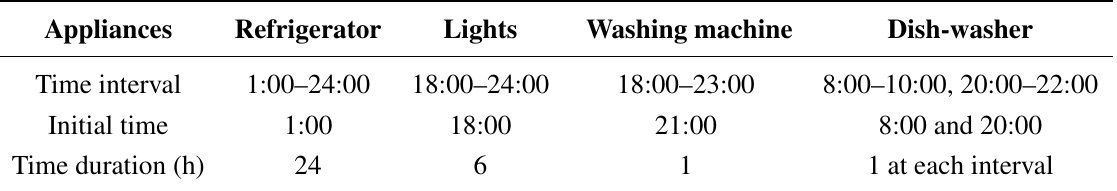
Table 2. Working time of household appliances except plug-in electric vehicle: for the case without energy consumption scheduling function deployment, each appliance is assumed to start operation right at the initial time; for the case with energy consumption scheduling function deployment, the timing for the operation of each shiftable appliance is determined by the game result.